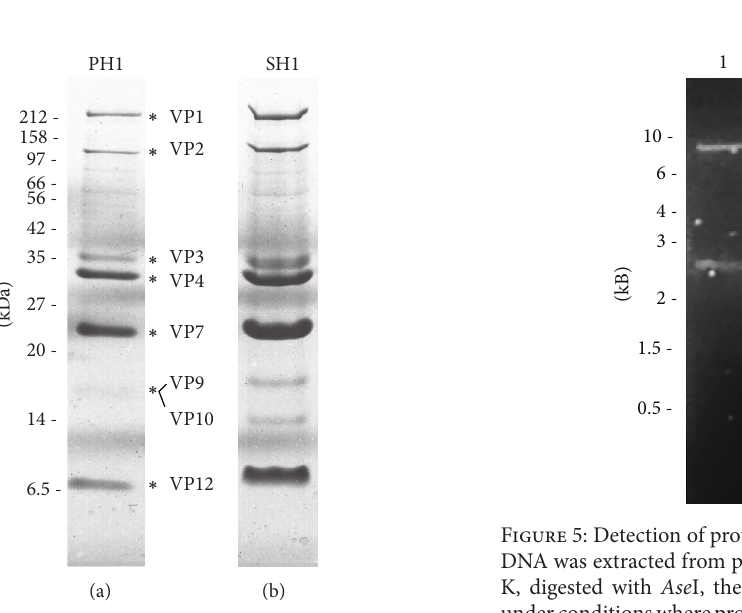
Figure 4: Structural proteins of halovirus PH1. Viral structural proteinswereseparatedbySDS-PAGEona12%(w/v)acrylamidegel and stained with Brilliant Blue G (a). They were run in parallel with the proteins of purified SH1 virus (b). The sizes of protein standard markers are indicated on the left side (in kDa). Asterisks denote proteins bands of PH1 that were identified by mass spectroscopy.